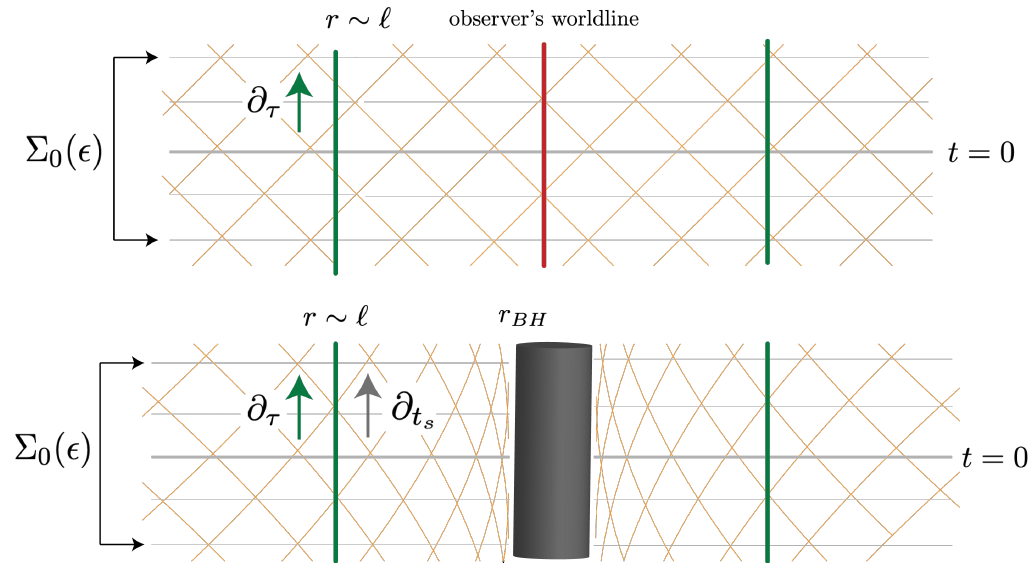
( (cid:15) ) about it and replacing 0